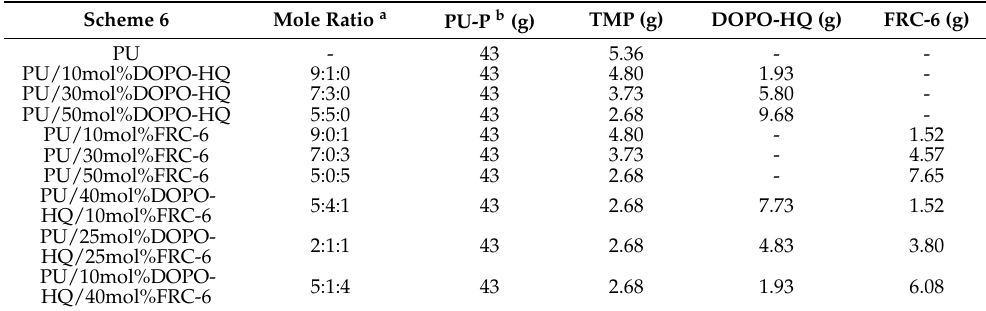
Table 1. Feeding ratio of IFRPU-PSA samples.